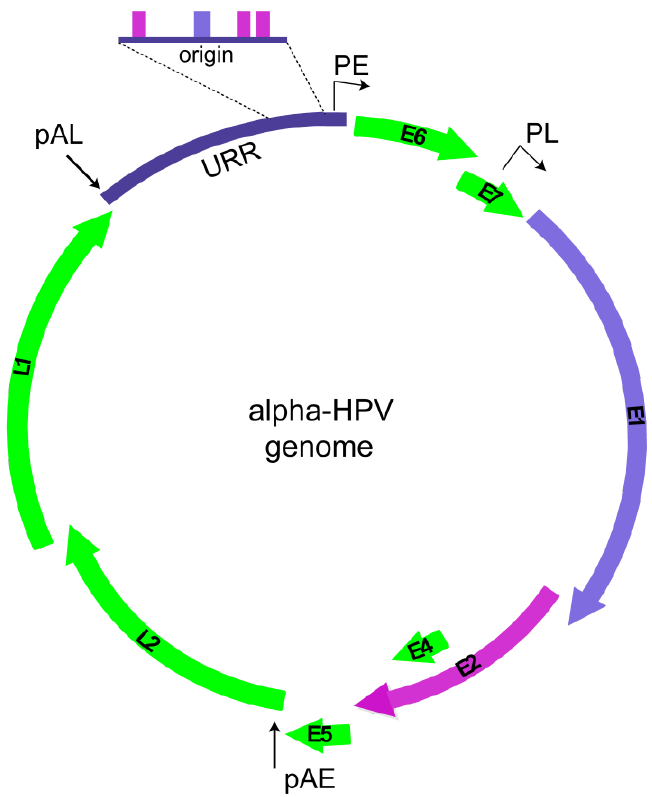
Figure 1. Viral genome. The circular dsDNA genome of an alpha-HPV genome is shown. Viral open reading frames are depicted as curved arrows. The URR (upstream regulatory region) is expanded to show the replication origin containing binding sites for the E2 protein (magenta boxes) and the E1 binding site (purple rectangle) are shown. The early promoter (PE), late promoter (PL) and early and late polyadenylation sites (pAE and pAL) are indicated.